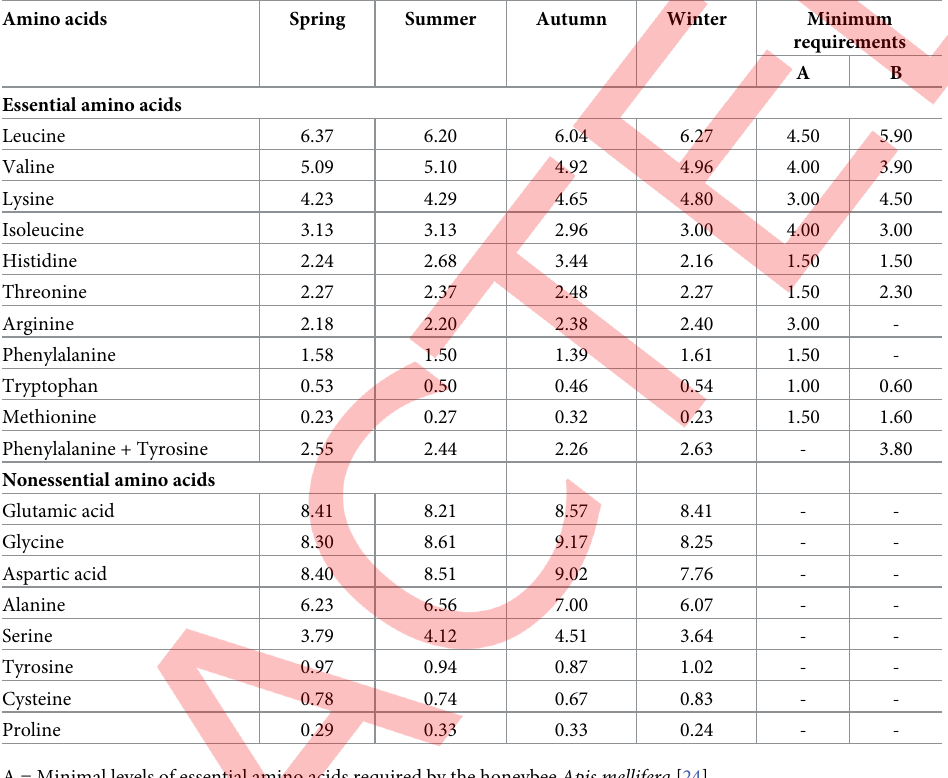
Table 5. Amino acids (g/100 g protein) in bee pollen compared to the minimum requirements of honeybees ( Apis mellifera L.) and adult